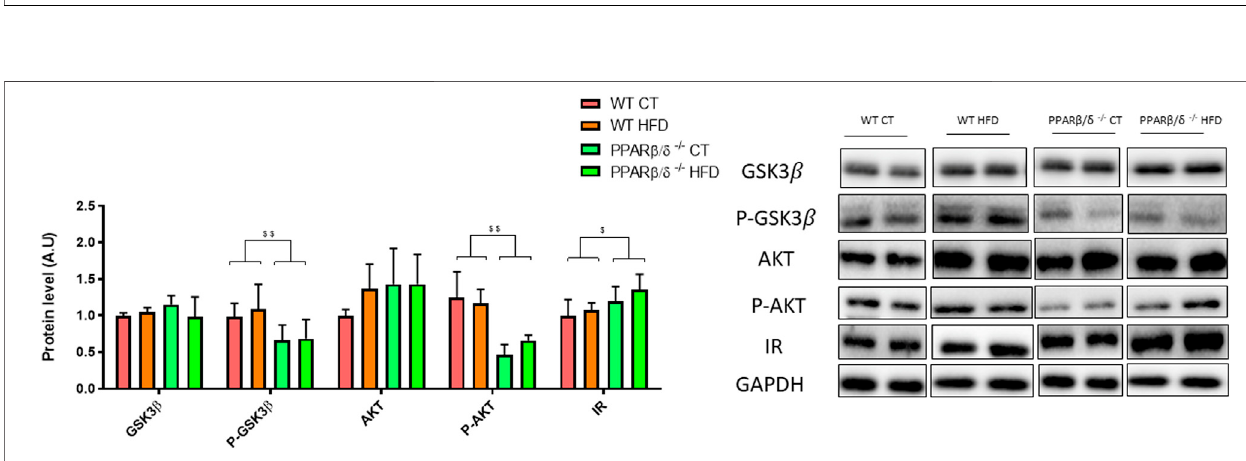
FIGURE7| Immunoblotdetection ofIRand relatedsignaling proteinswheretworepresentative samplesoutoffour per group areshown. Allresults arepresented as MEAN ± SD. Groups were compared against each other using two-way ANOVA ( n ≥ 4) (WT vs. PPAR β / δ -/- : $$ denote p < 0.01; $ denote p <